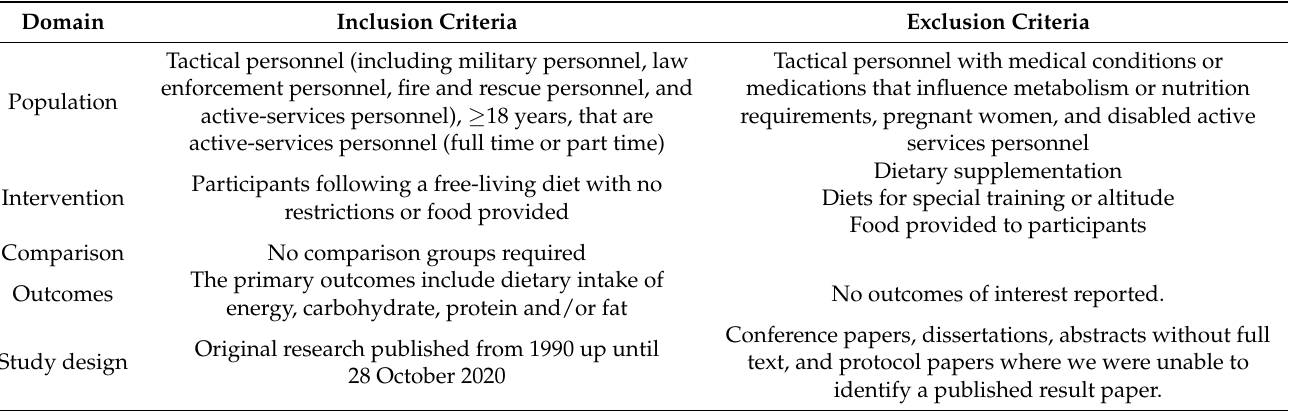
Table 1. Eligibility criteria for each domain for a systematic review of studies reporting dietary intake in tactical personnel, according to the Preferred Reporting Items for Systematic Reviews and Meta-Analyses framework